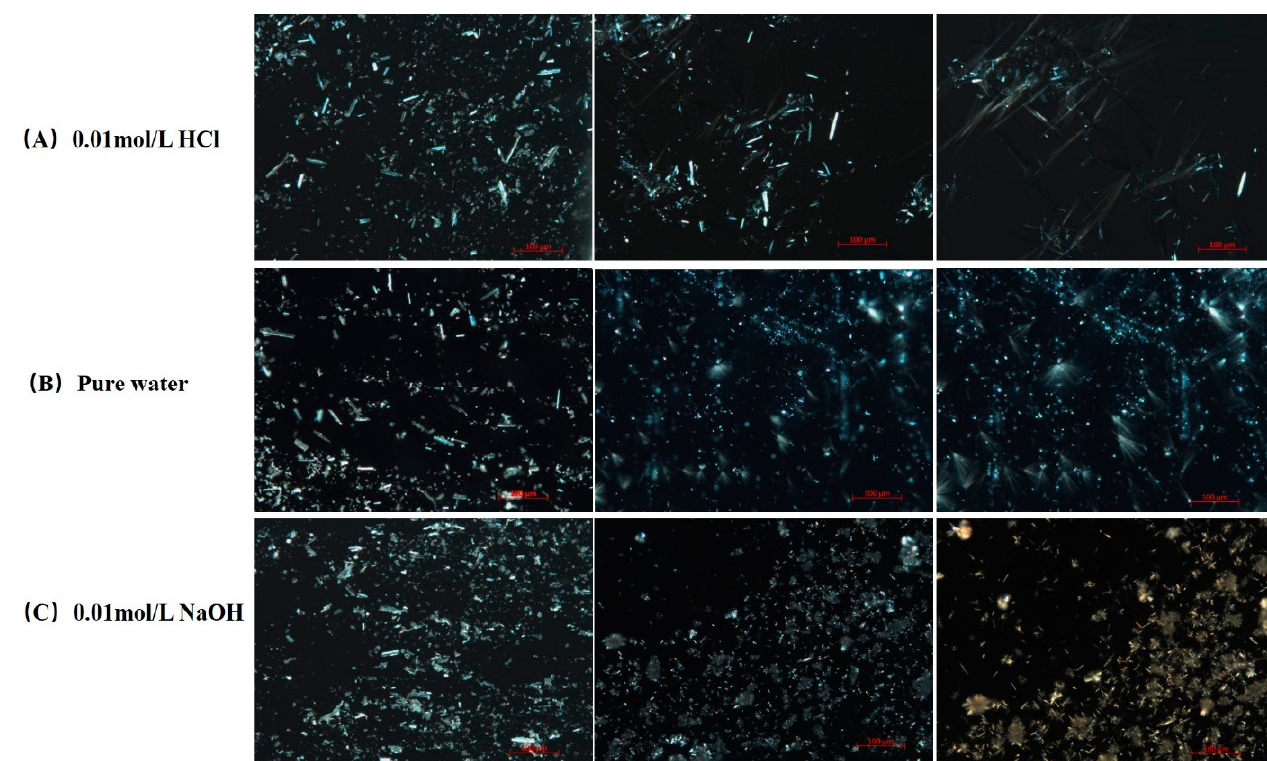
Figure 8. PLM images of dissolution and precipitation of pure FXD in various dissolution media under 200× magnification. ( A ) 0.01 mol/L HCl, ( B ) pure water, ( C ) 0.01 mol/L NaOH. Full pixel pictures are available in the Supplementary Information Figure S4 – S6.